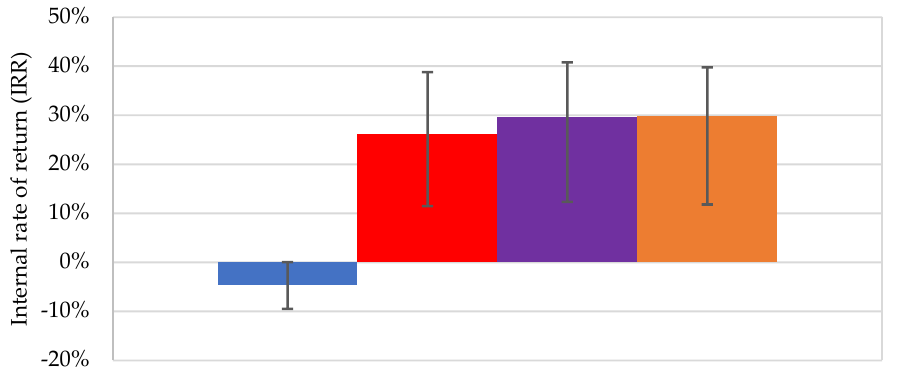
typical days (5.8 h) to a single typical day (1.2 h) for the technology selection (results Figure 5. The energy price sensitivity analysis. obtained using an i5-10400F with 4.3 GHz, 6 cores and 12 threads).